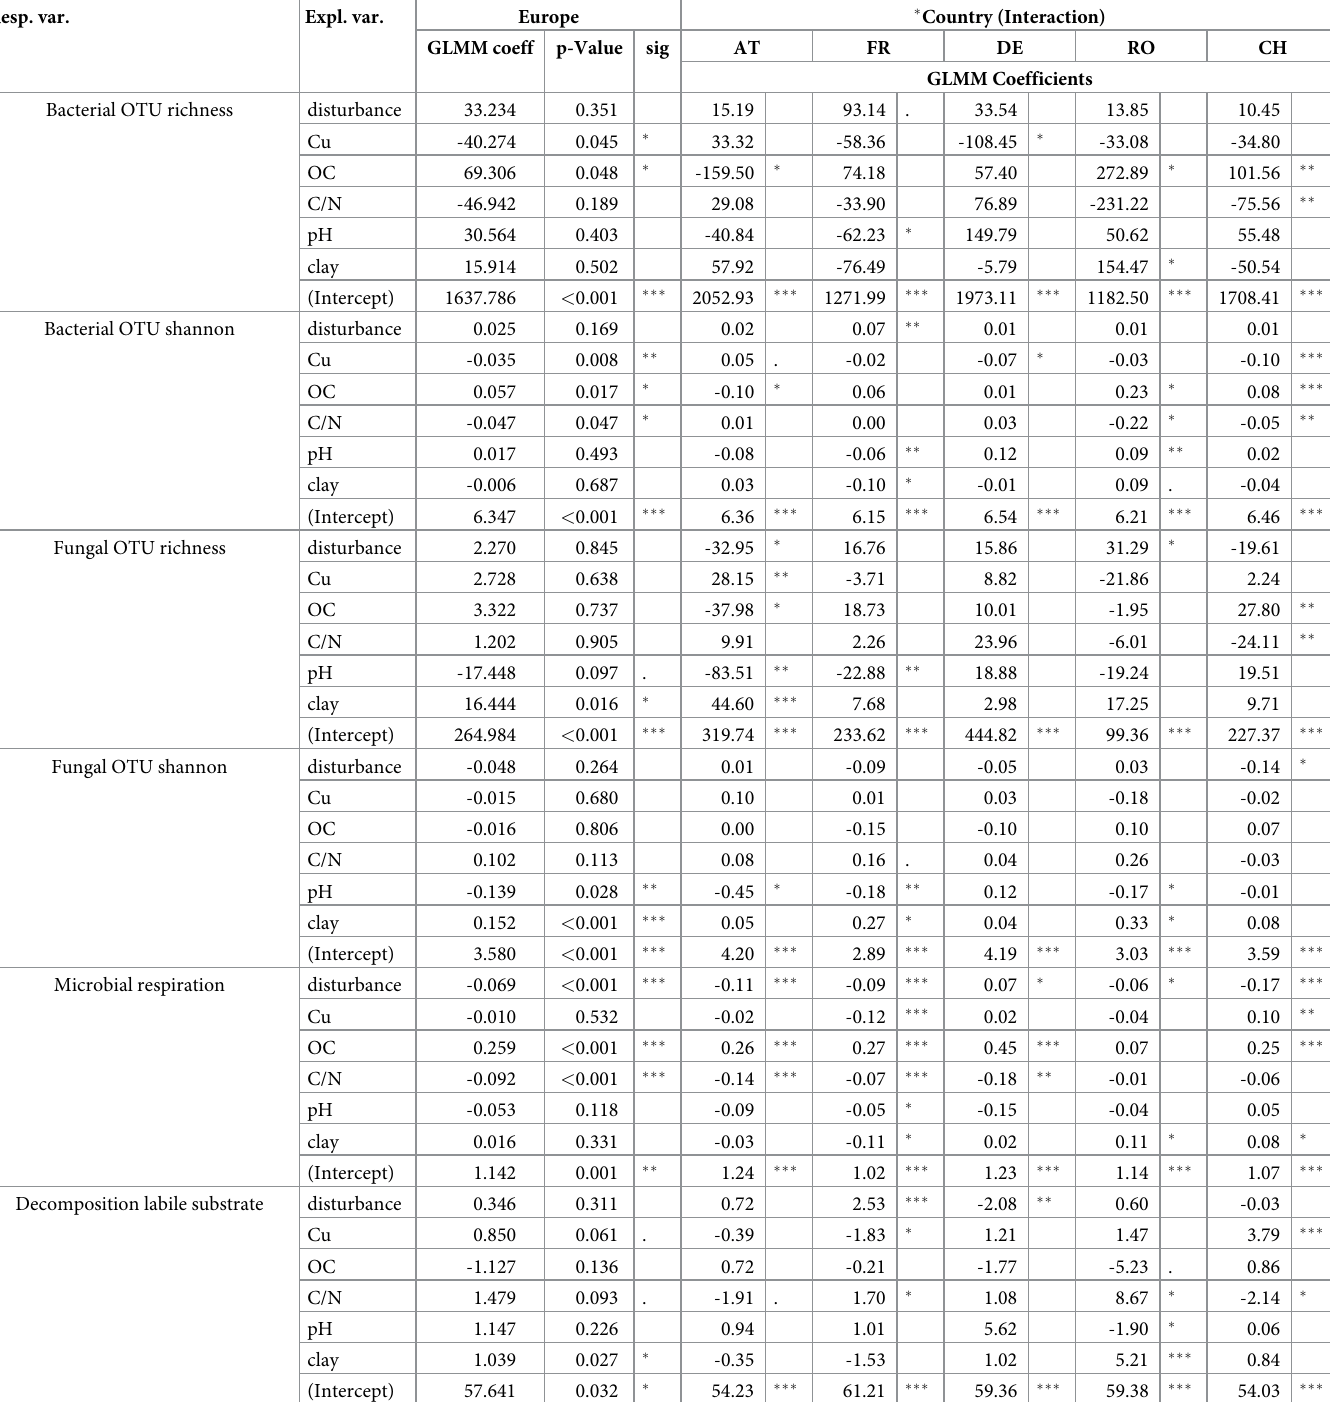
Table 2. Analysis summary showing Type III Analysis of Variance (ANOVA) summary of general linear mixed models for all included response variables (Resp. var.) and explanatory variables (Expl. Var.). Resp.